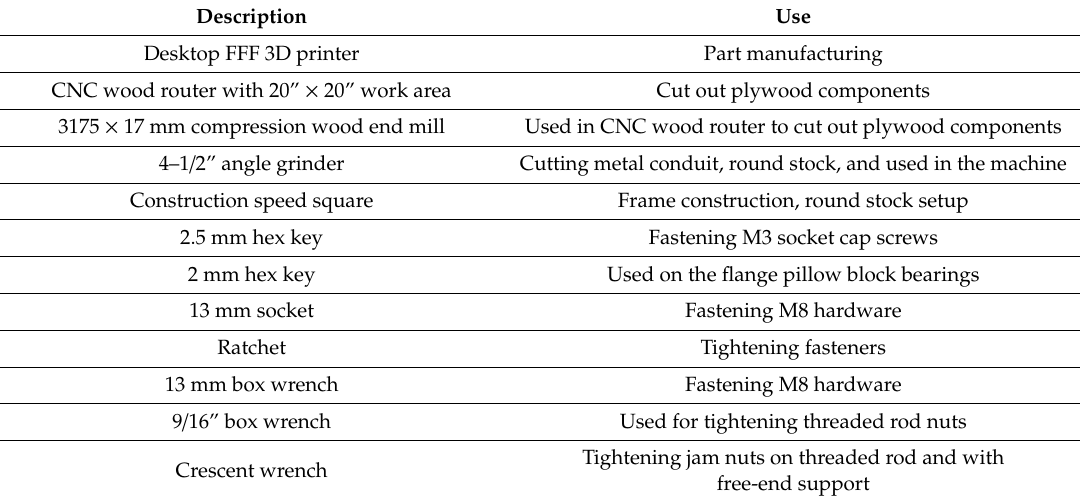
Table 2. Tools Used for the Fabrication of the Open-Source Grinding Machine for Compression Screw